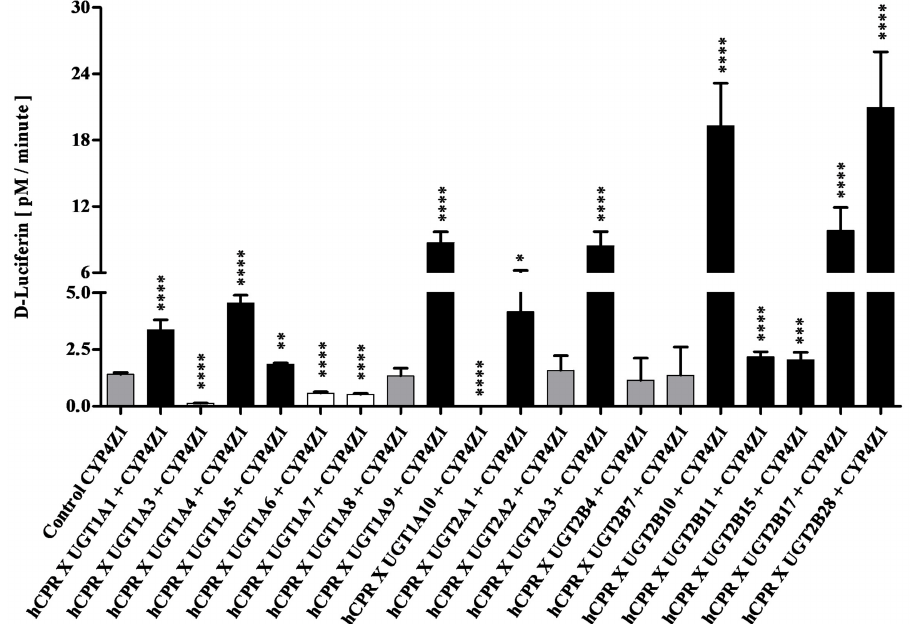
Figure 4. Enzymatic activities of enzyme bags prepared from diploid strains co-expressing CYP4Z1, CPR, and different UGTs as indicated. Activities towards the substrate Luciferin-4FBE are shown in comparison to the control strain SAN500 (which co-expresses CYP4Z1 and CPR without a UGT). Activities that are not different from the control are shown in grey, while those that are statistically significantly higher or lower than the control are shown in black or white, respectively. * p <